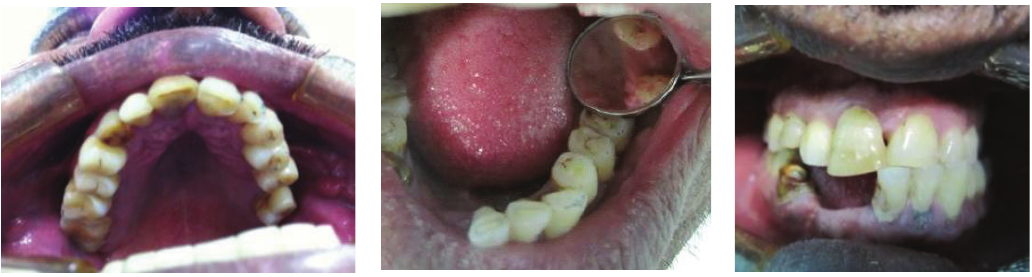
Figure 2: Intraoral view.